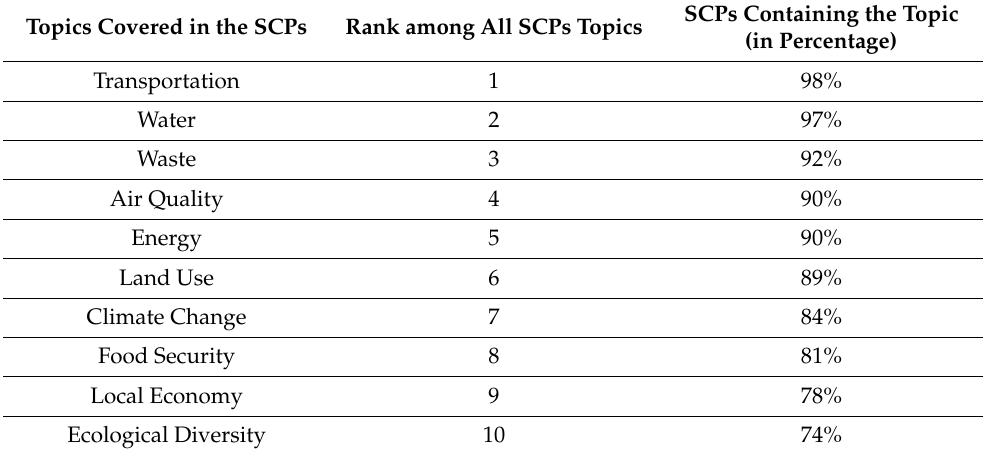
Table 1. Top 10 topics covered in Canadian SCPs. Topics Covered in the